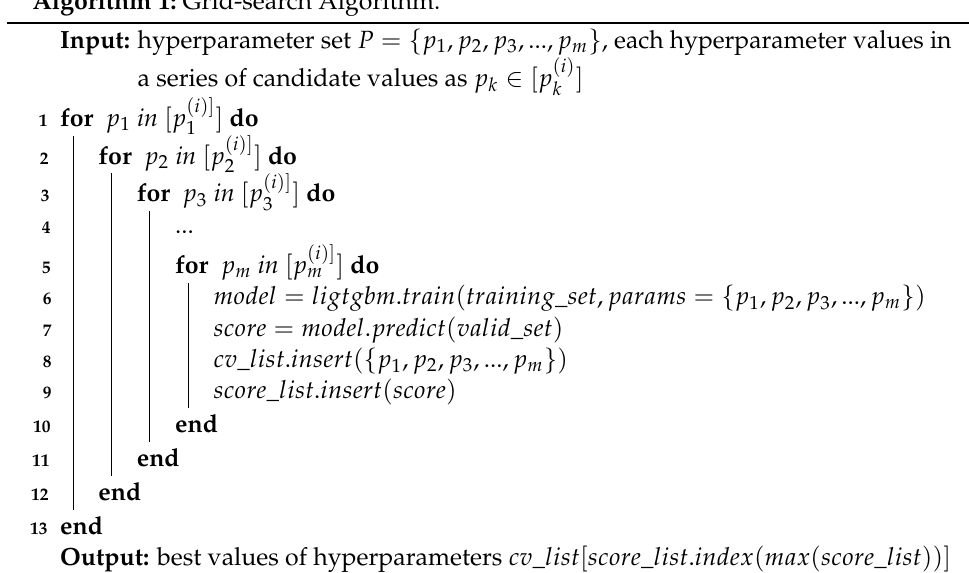
Algorithm 1: Grid-search